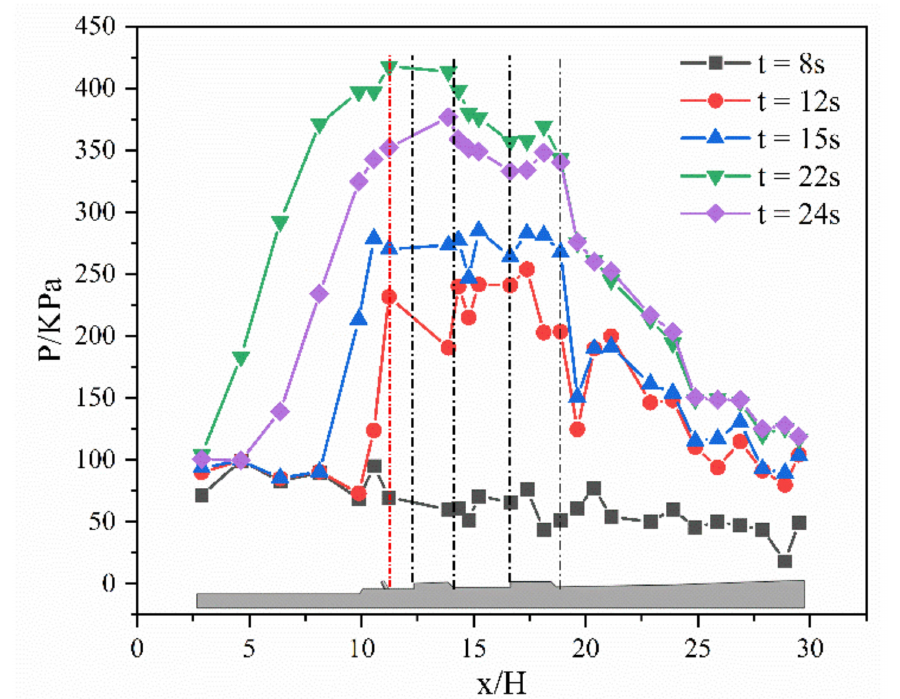
Figure 12. Pressure distribution along the wall surface of the SSRJ at different